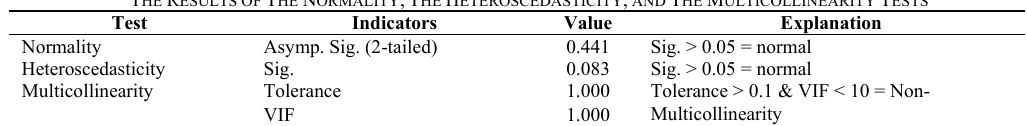
TABLE 4 T HE R ESULTS OF T HE N ORMALITY , T HE H ETEROSCEDASTICITY , AND T HE M ULTICOLLINEARITY T